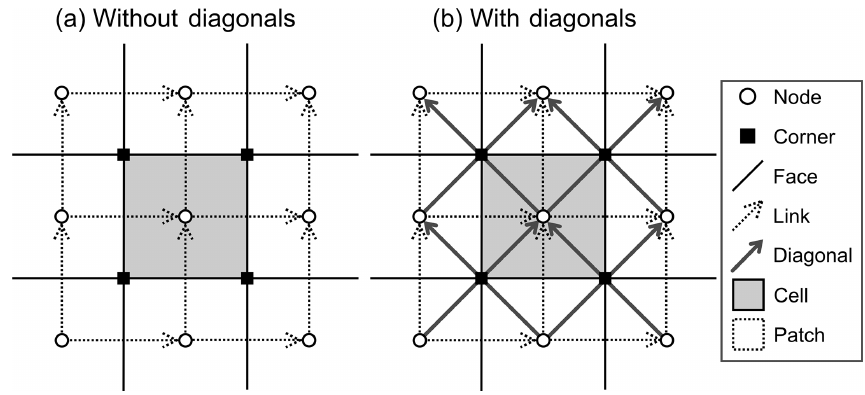
Figure 2. Grid elements of RasterModelGrid (a) without and (b) with diagonals.